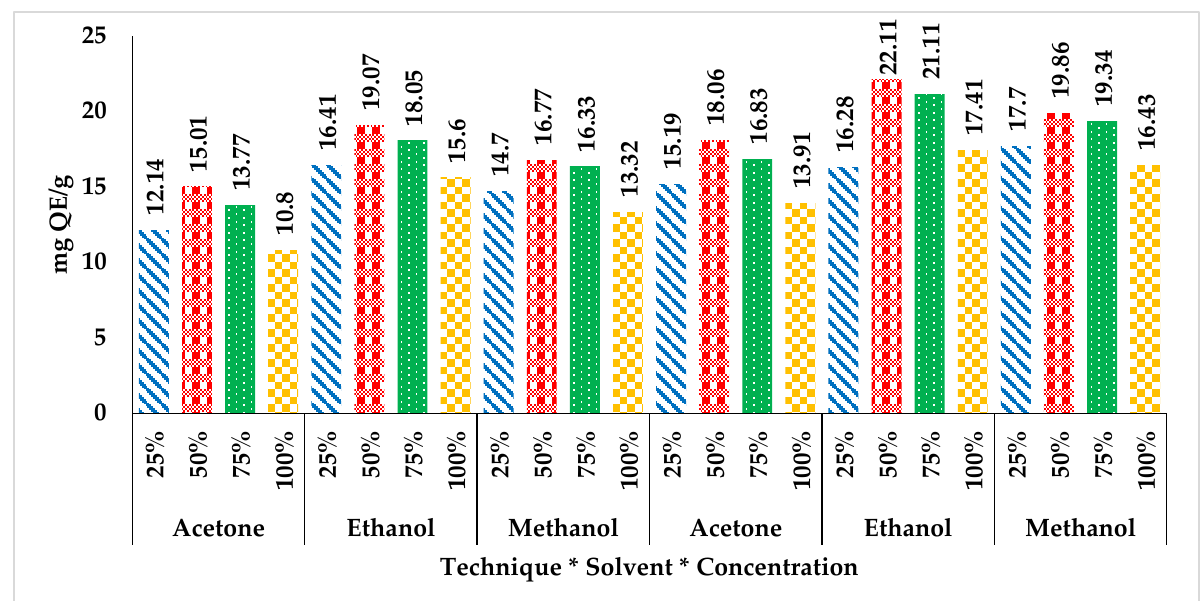
Figure 4. TFC of banana peel extracts.